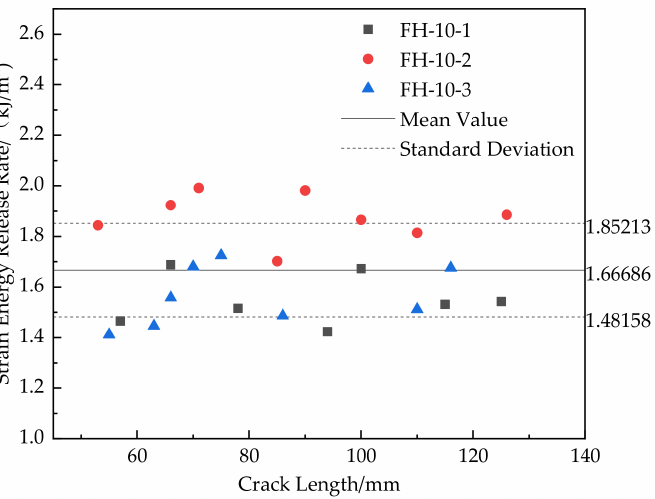
Figure 19. Release rate of critical strain energy of FH-10 with different crack